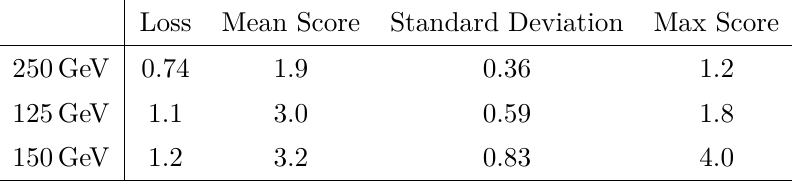
Table 1 . MLC Loss. Each entry corresponds to the injected cross section limit at which the plots from figure 2 and 3 cross the 2 σ band. The point of intersection is calculated as a linear interpolation between data points. These are taken from figure 3 unless the crossing occurs outside of that range.